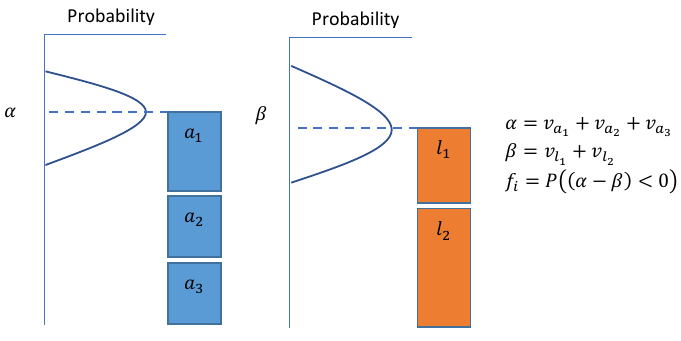
Figure 1. An asset-liability assignment with a failure